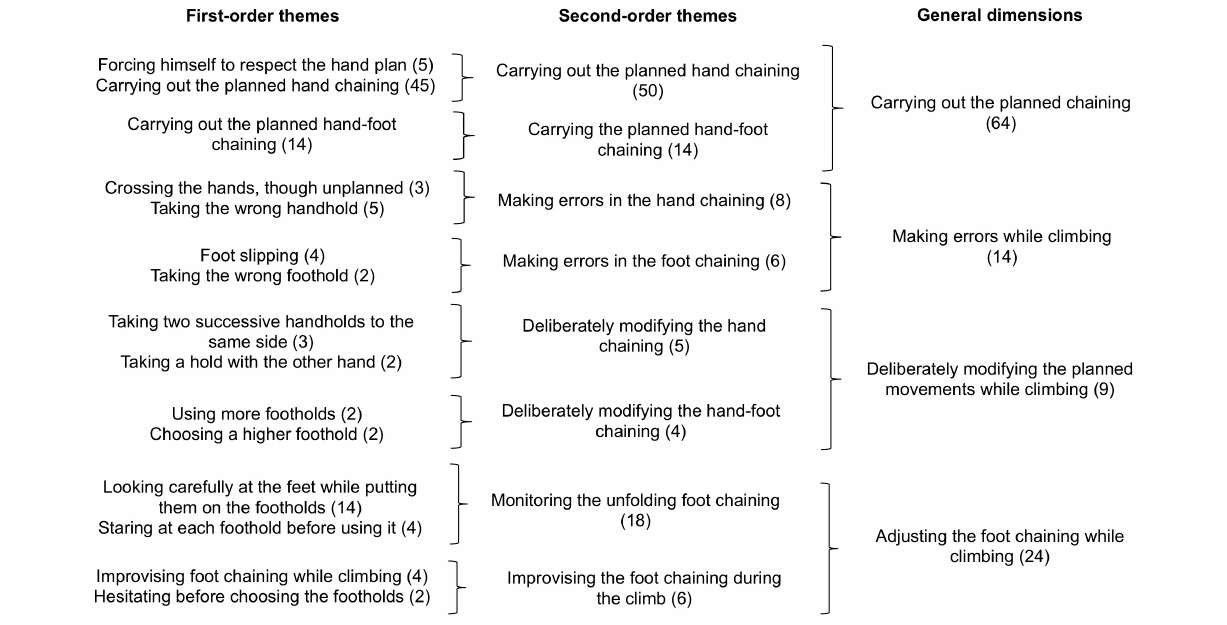
FIGURE 2 | Thematic analysis of the climber’s actions. The first column presents the first-order themes. The second column presents the second-order themes (i.e., merging of the first-order themes). The third column presents the general dimensions (i.e., merging of the second-order themes). The numbers in parentheses associated with each theme refer to the number of occurrences identified from the